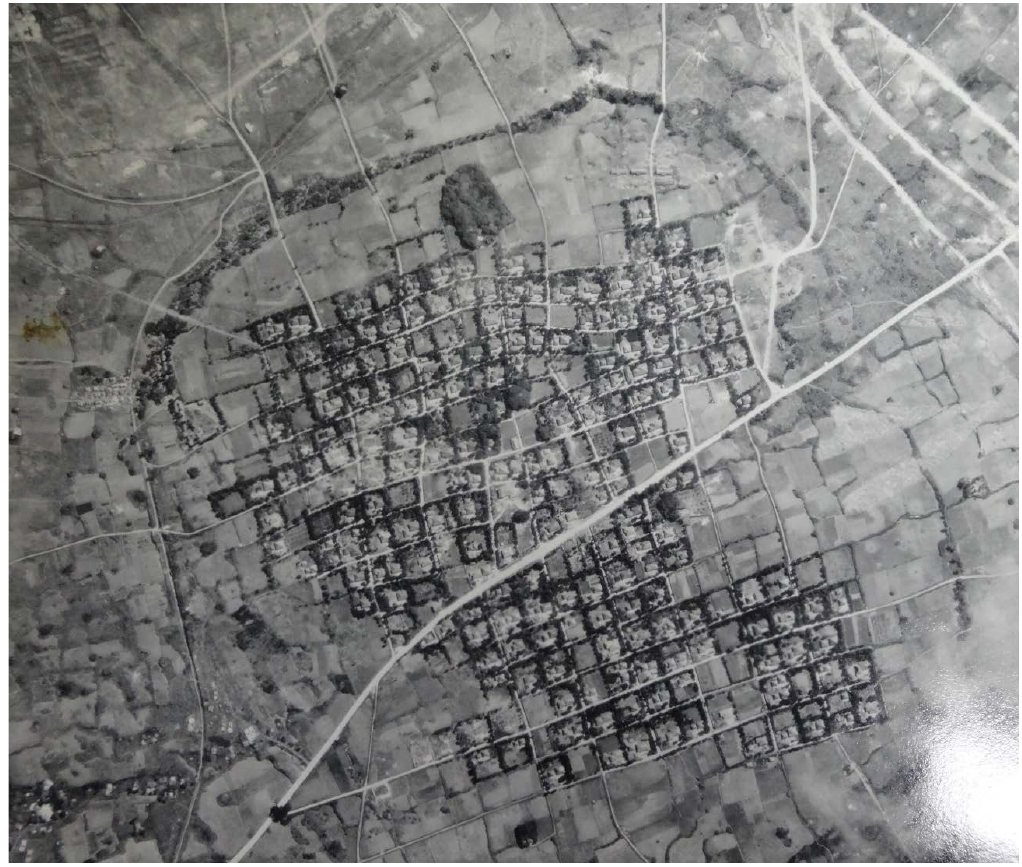
Figure 2. Aerial photo of ( upper ) Hirae and ( lower ) Maezato taken by the United States Army in 1945. (source: library of Cheju University, South Korea).